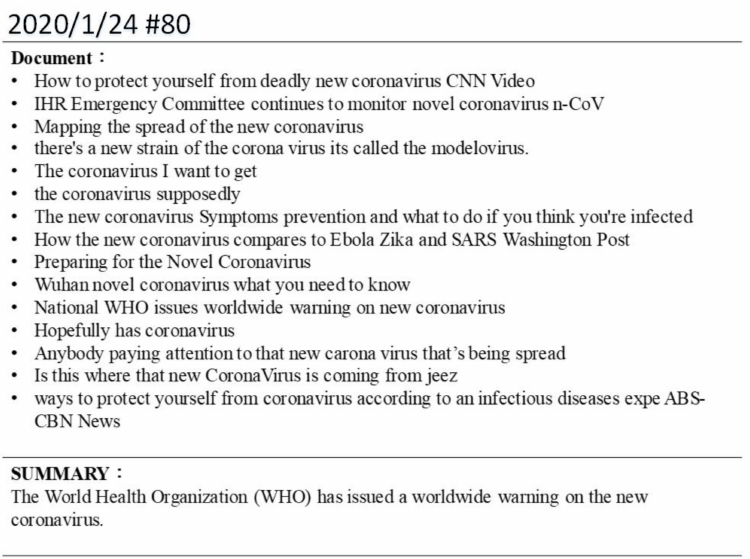
Figure A4. A sample resulting summary of formulated event topics (24 January 2020).